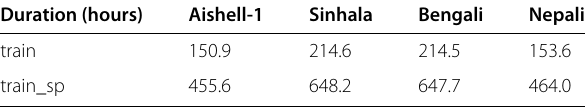
Table 4 Comparison of the duration of the four source